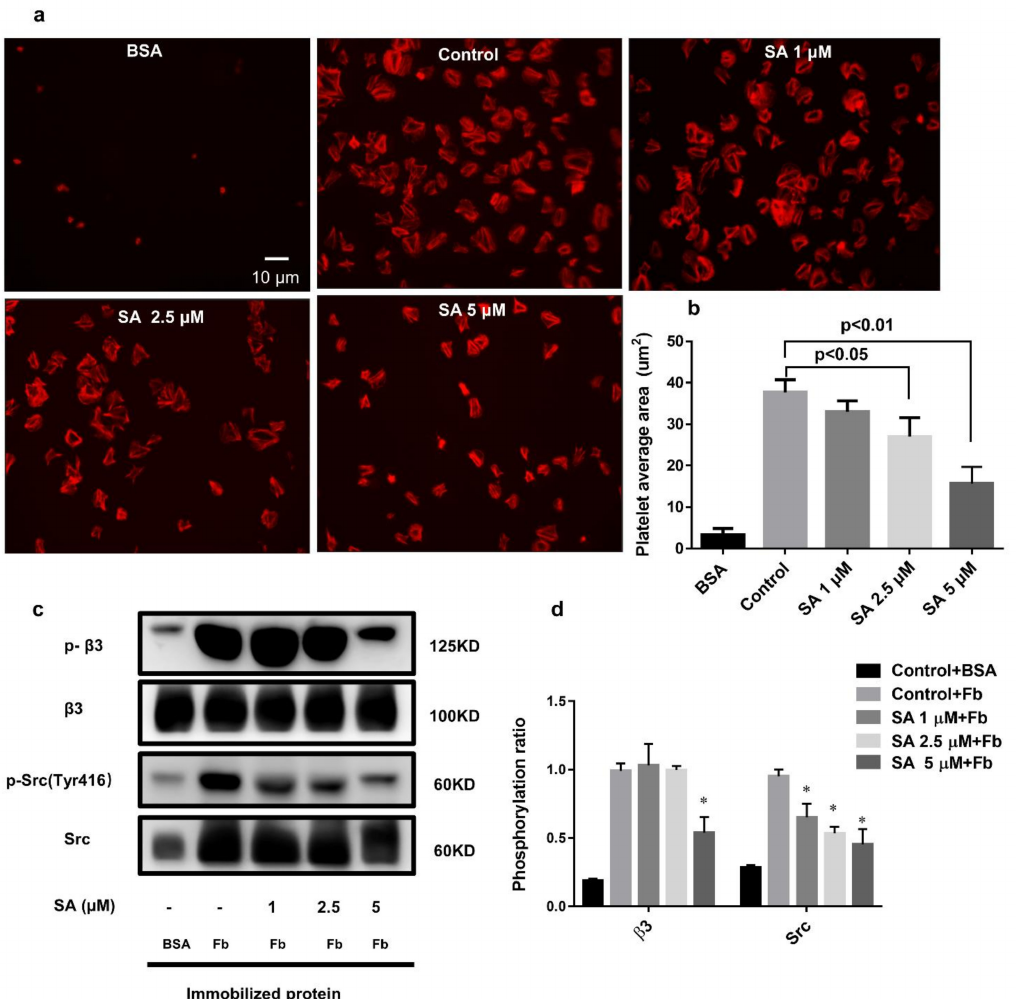
Figure 7. Sanguinarine dose-dependently represses human platelet spreading on the fibrinogen-coated surface and inhibits integrin α IIb β 3-mediated outside-in signaling. ( a ) A representative image of platelets spreading on the coated BSA or fibrinogen cover glasses. ( b ) The figure expressed the quantity of the single adherent platelet area as shown in the right